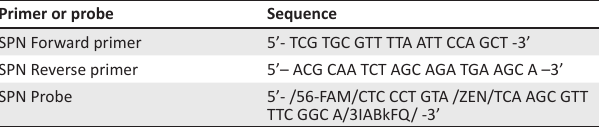
TABLE 1-A1: Primer and probe sequences used for lytA PCR assay.